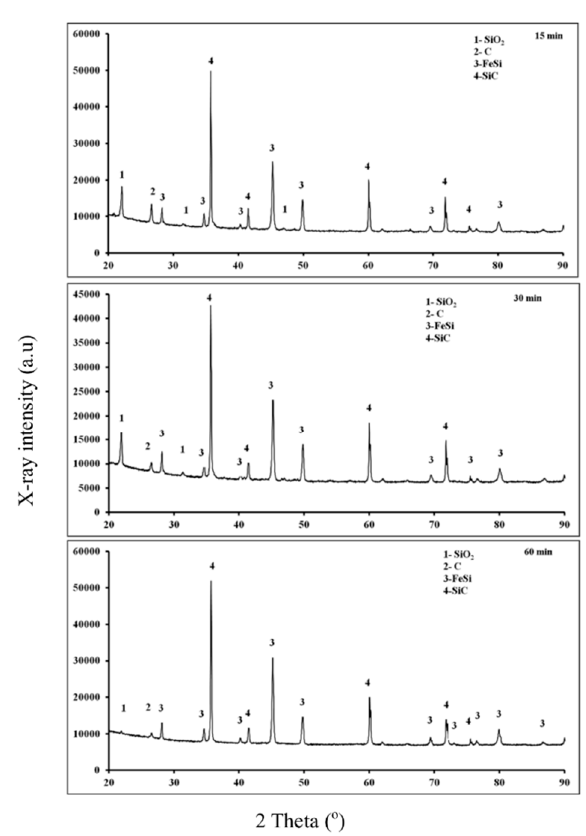
Figure 5. X-ray diffraction results from reacted assemblies after a range of reaction times. Phases present were identified as: (1) unreacted SiO 2 , (2) unused graphite, (3) FeSi alloy, and (4) SiC.